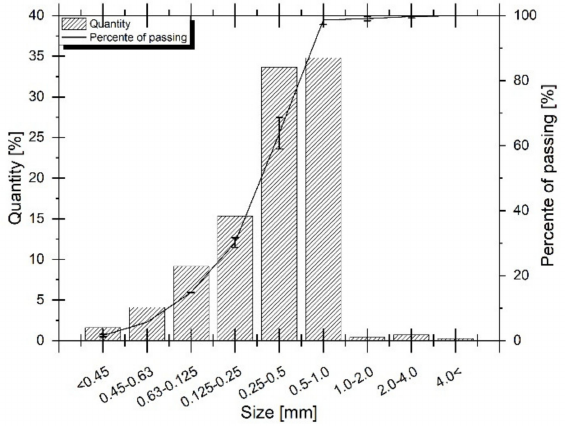
Figure 2. Sieve analysis of the GTR